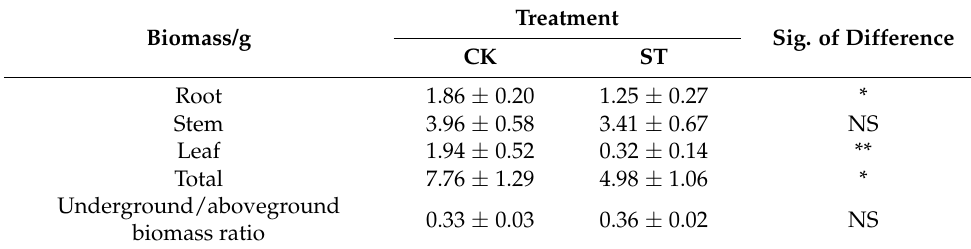
Table 2. Response of biomass allocation in the seedlings of C. hongkongensis subsp. tonkinensis to salt-stress for 60 days.